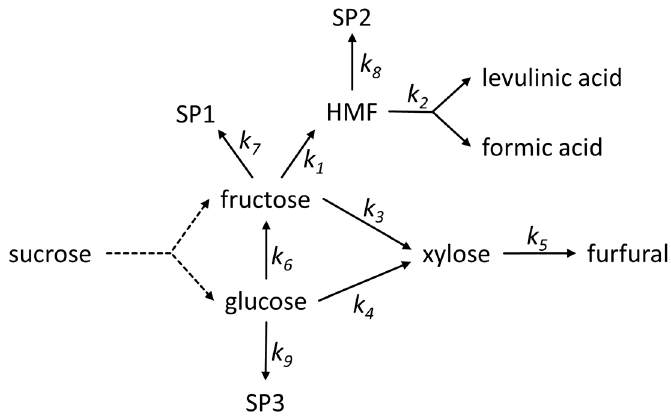
Figure 2. Reaction model to determine the kinetic rate coefficients k n of the acid-catalyzed conversion of sucrose. HMF = hydroxymethylfurfural; SP = side products.